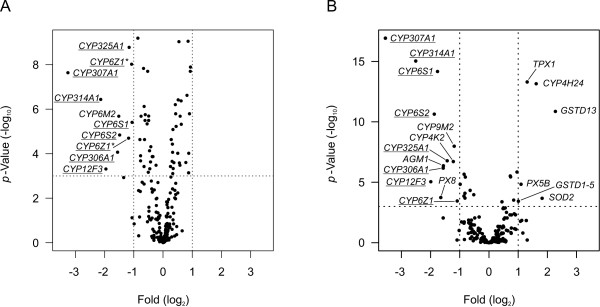
Microarray analysis comparing females with males within each strain. Data are shown for the gene expression levels of susceptible Kisumu females vs. males (A) and the permethrin resistant Odumasy females vs. males (B). Each dot represents the mean estimates, fold (M) and p-value (adjusted for multiple testing), for one gene from the complete microarray experiment. Names are shown for genes that are at least two-fold differentially expressed. Underlined names show genes that are common to both the Kisumu female-male and the Odumasy female-male comparison. Horizontal line represents the level of significance α = 0.001, and vertical lines indicate two-fold change threshold. *CYP6Z1 was spotted on the detox chip as both cDNA and 70-mer oligonucleotide probe [16].